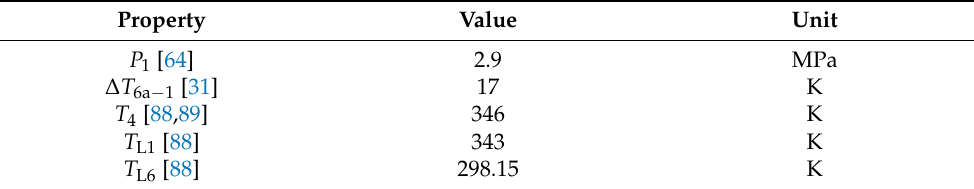
Table 6. Selection of the main operating parameters of the DORC